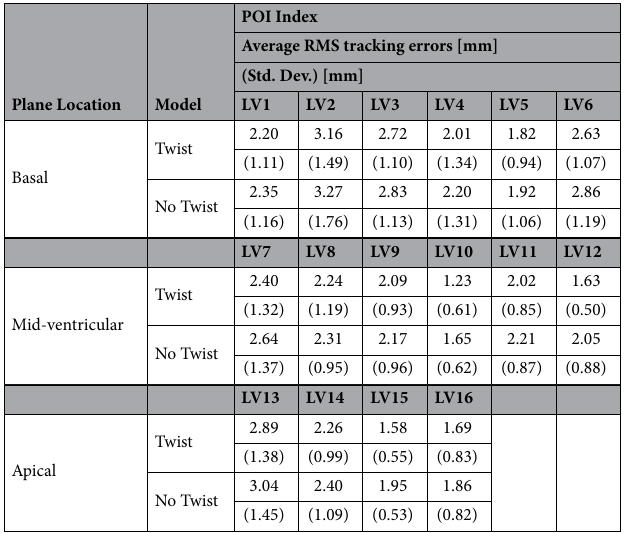
Table 5. The summary of the results for the 16-point LV endocardium model. The averages and standard deviations of RMS tracking errors across the eight Cine MR datasets are given. Results are shown with and without the twisting in the deformable model.